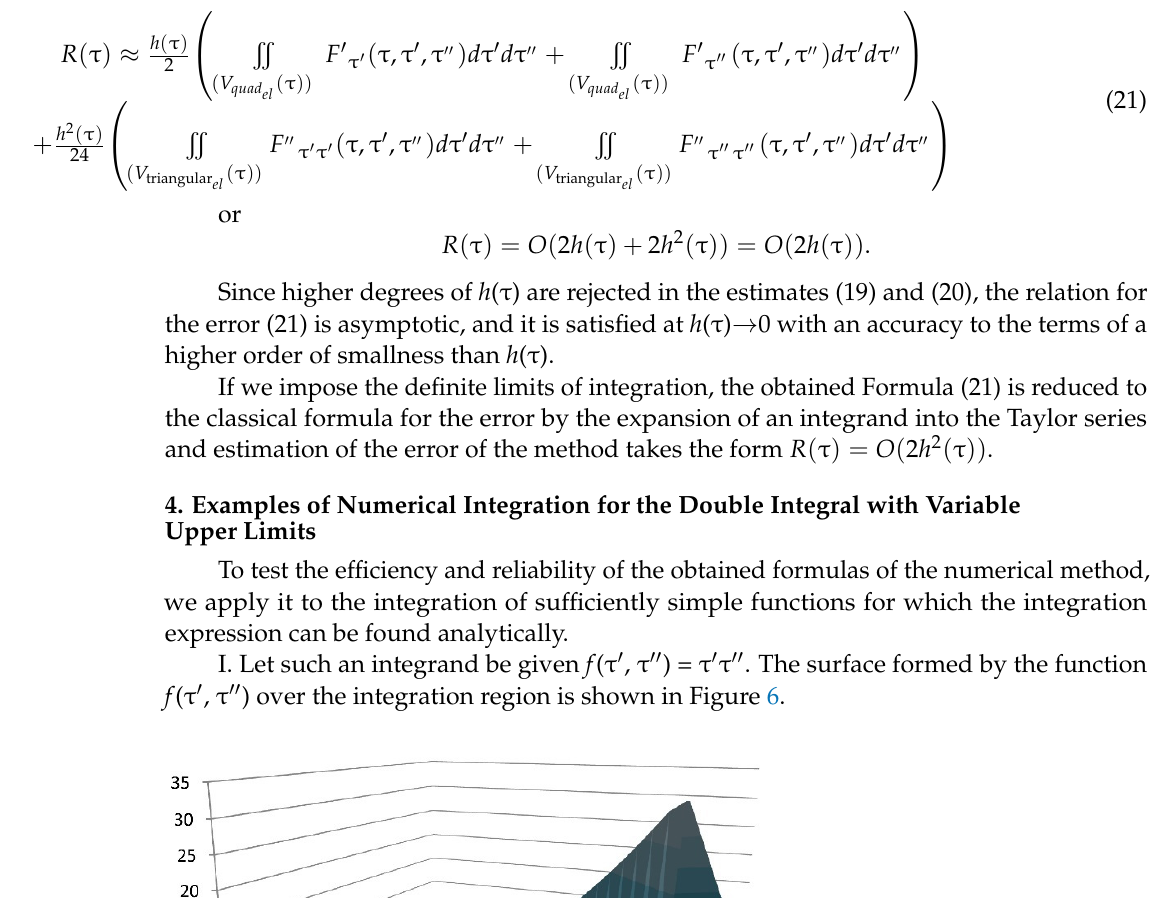
Table 1. Calculation of integral  